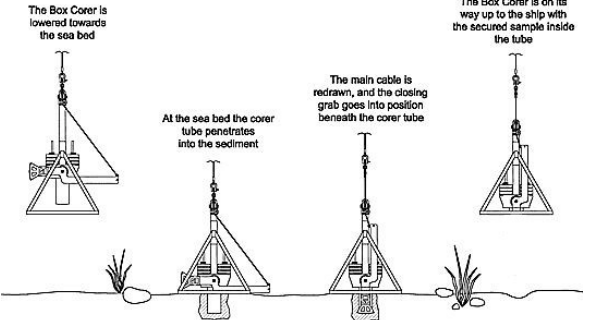
Figure 14. Detail of the box corer when it reaches the bottom.